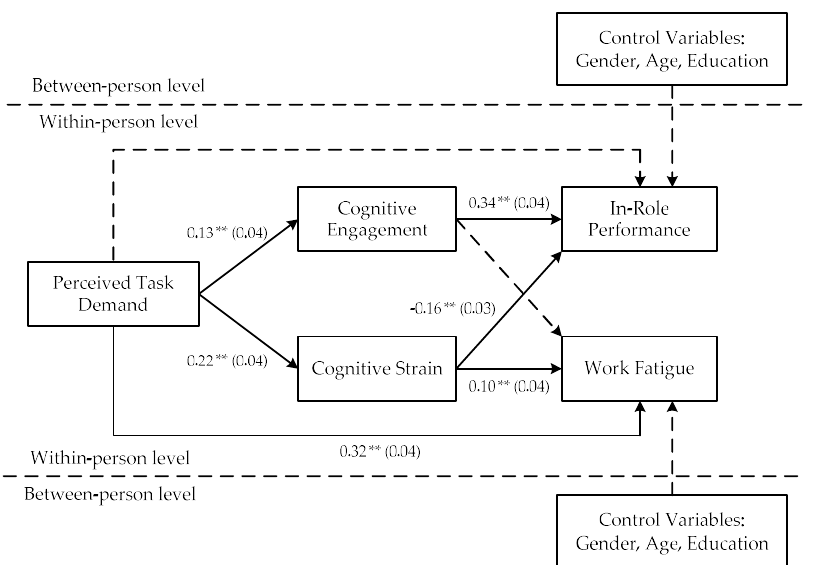
Figure A1. Conceptual model and results of the multilevel structural equation model with control variables. Notes: Values in parenthesis are standard errors; parameters are unstandardized; ** p < 0.01.